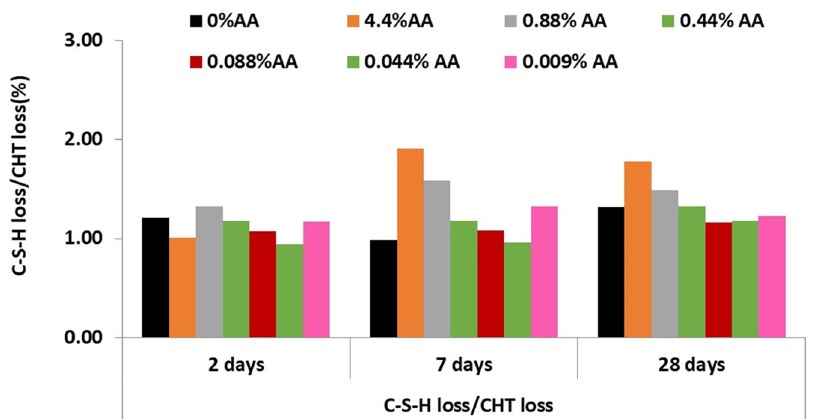
Figure 10. Gel C-S-H/Portlandite ratio (wt.%) of cement pastes with AA.